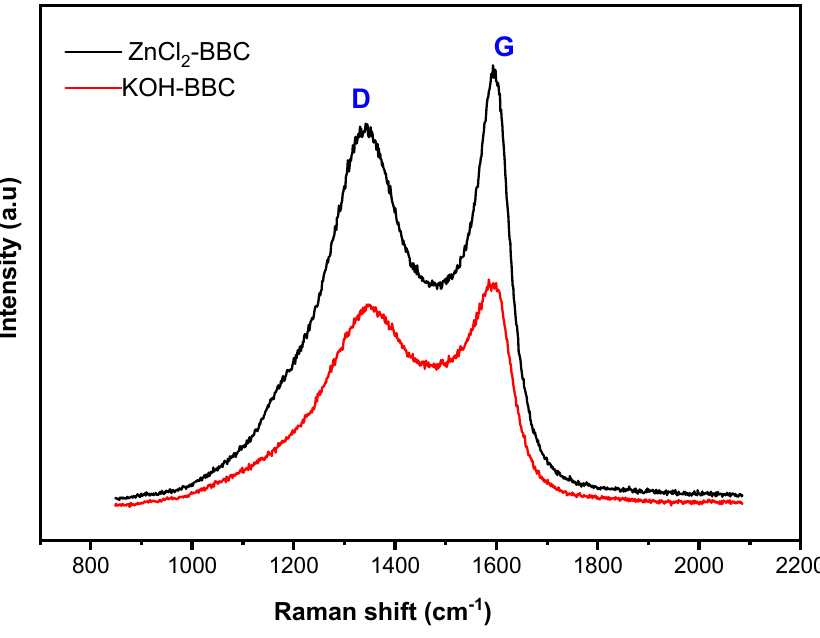
Figure 4. Raman spectra of BBC samples.